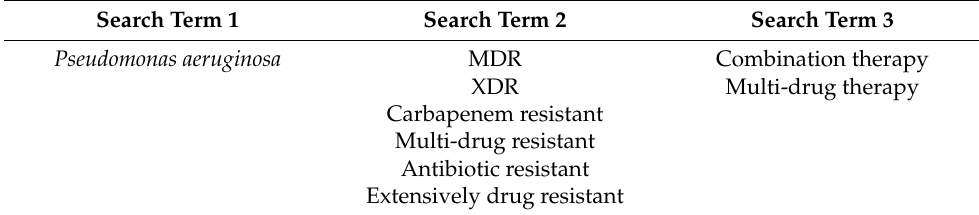
Table 7. Key words used for the literature search.